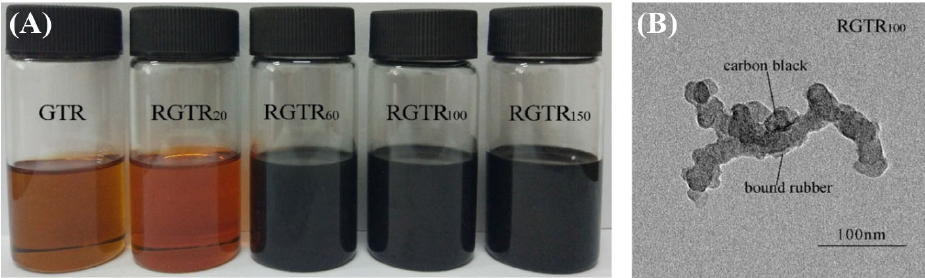
Figure 3. ( A ) Sol fractions obtained from degraded rubber with types of soybean oil under 150 °C for 4 h; ( B ) TEM image of CB from RGTR 100 [26].